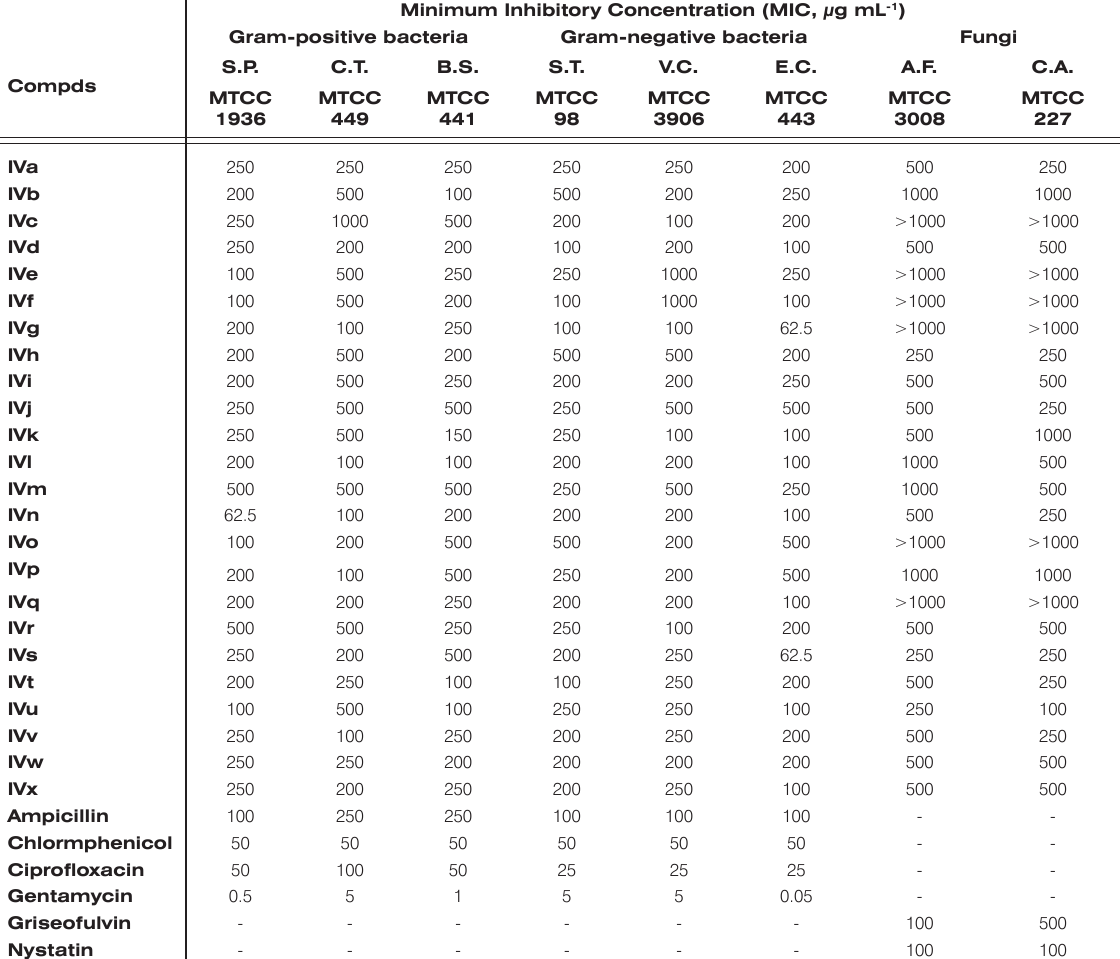
Table 1. Antibacterial and antifungal activity of compounds IVa-x .